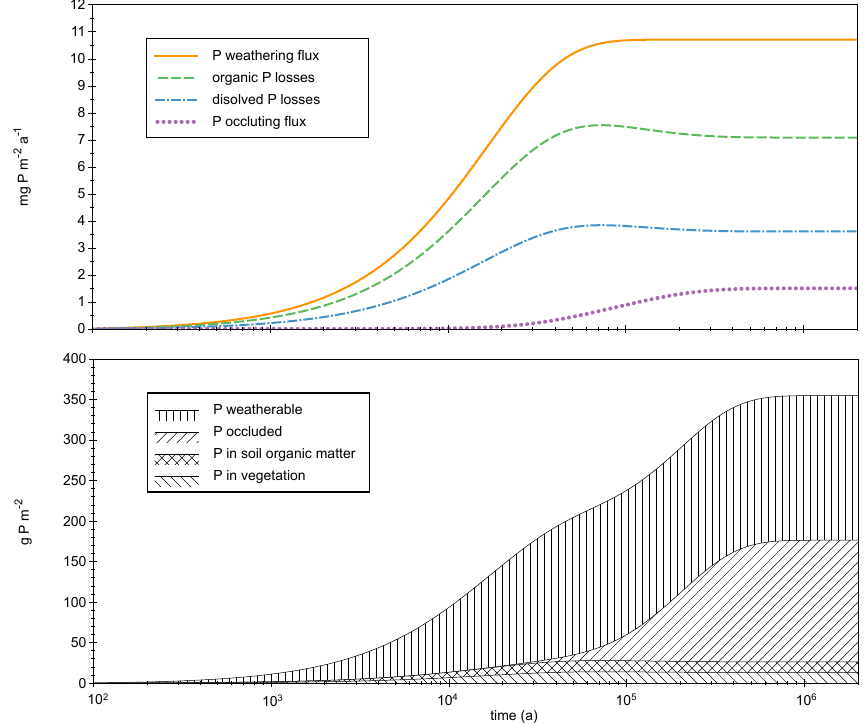
Fig. 7. Modelled P dynamics for an ecosystem with slow uplift rates. This simulation uses the climate and atmospheric input for the Amazon Basin, found in Tables 2 and 3. The upper figure shows the evolution of the fluxes as the soil is formed, and the lower figure shows the evolution of the P pools. Note that the x-axis is plotted on a logarithmic